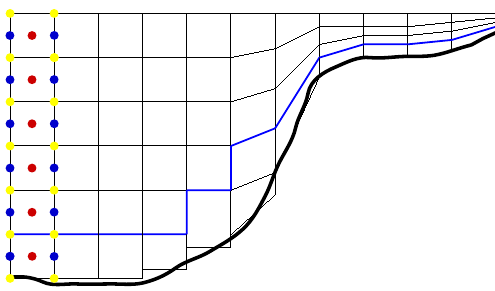
Figure 2. Schematic of vertical discretization. The thick line repre- sents the bottom; the thin lines represent the layer boundaries and vertical faces of prisms. The locations of variables are shown for the left column only. The blue circles correspond to scalar quanti- ties (temperature, salinity, pressure), the red circles to the horizontal velocities and the yellow ones to the vertical exchange velocities. The bottom can be represented with full cells (three left columns) or partial cells (the next two). The mesh levels can also be terrain- following, and the number of layers may vary (the right part of the schematic). The layer thickness in the ALE procedure may vary in prisms above the blue line. The height of prisms in contact with the bottom is